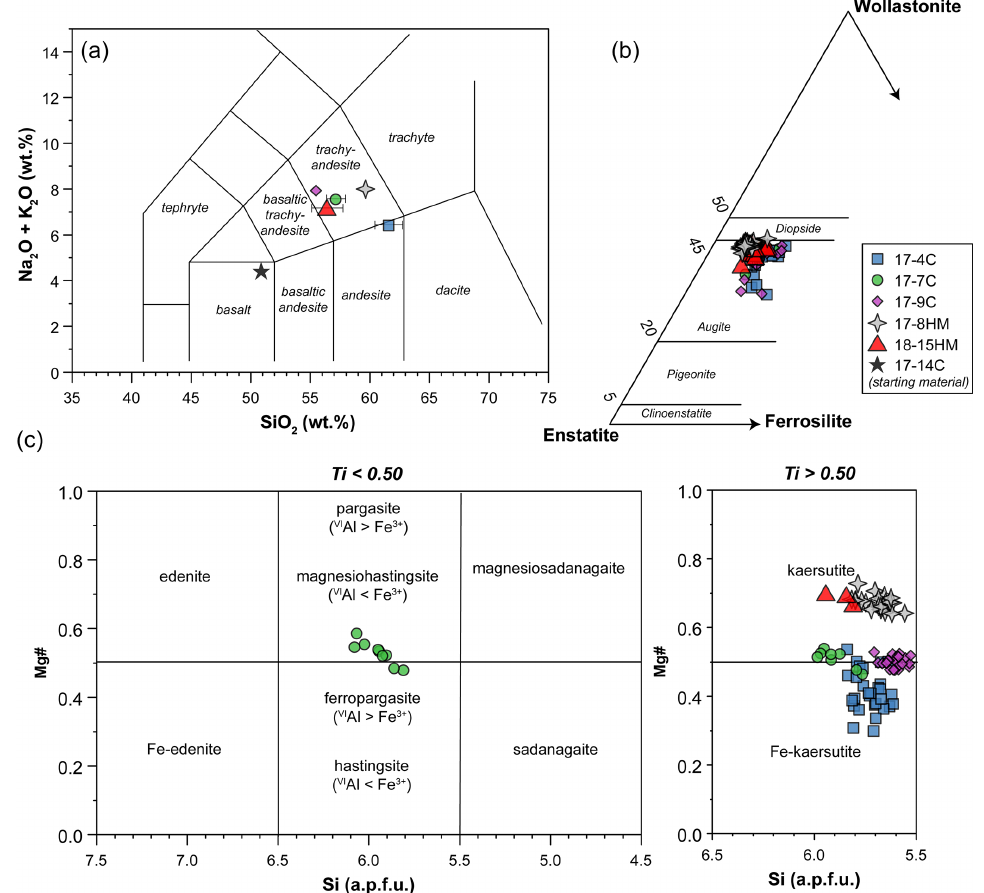
Figure 3. Major element compositions of glass (a) , clinopyroxene (b) , and amphibole (c) . In (a) glass compositions represent average values of data normalized to 100wt%. When not visible, the error bar is smaller than the